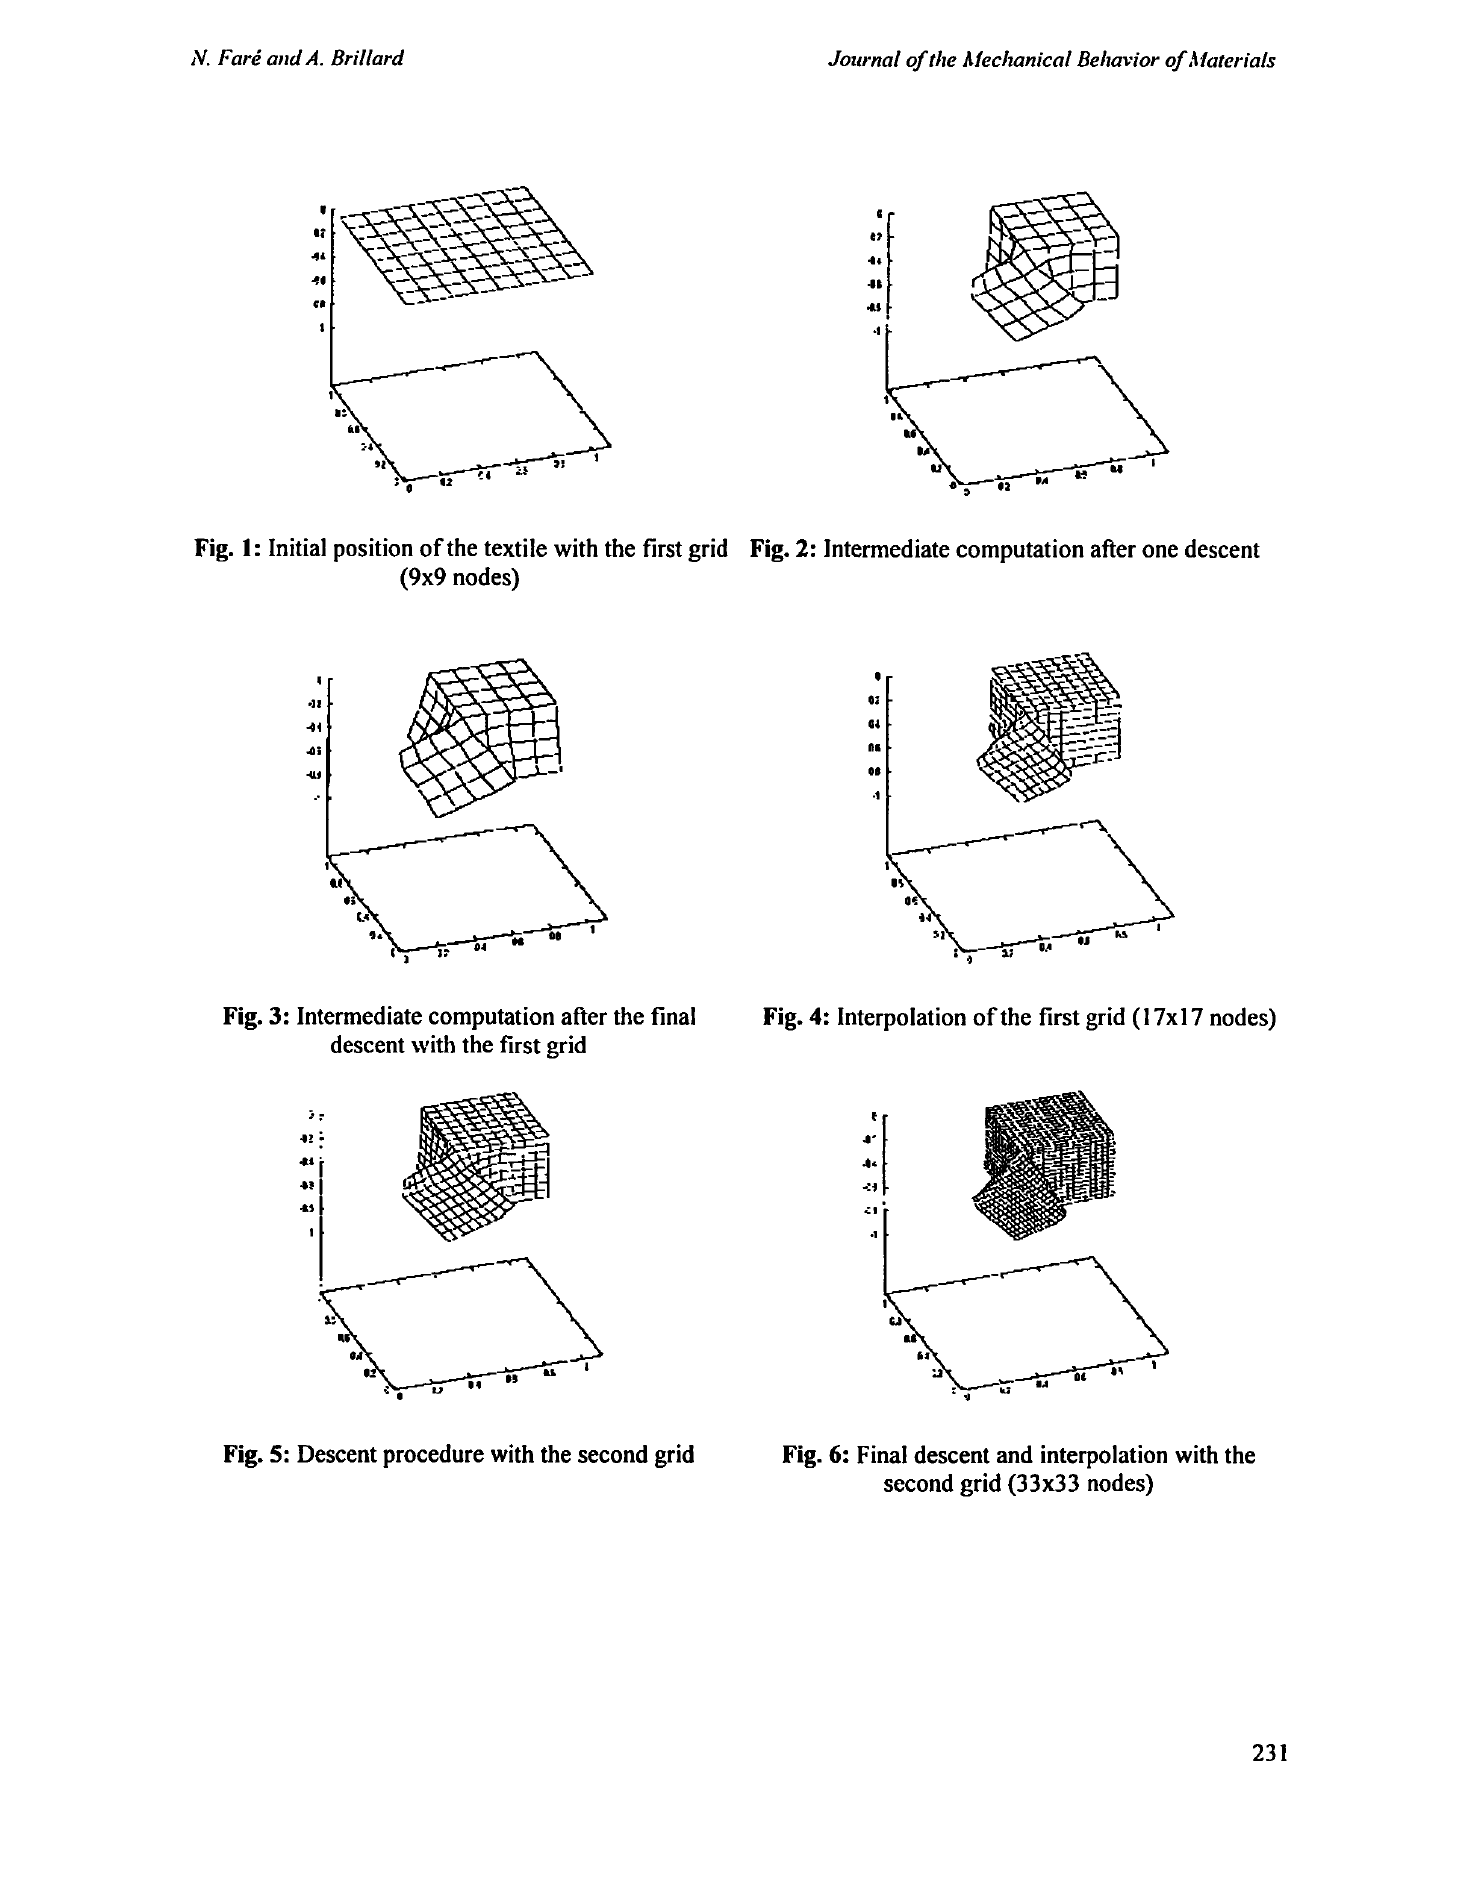
Fig. 5: Descent procedure with the second grid Fig. 6: Final descent and interpolation with the second grid (33x33 nodes)